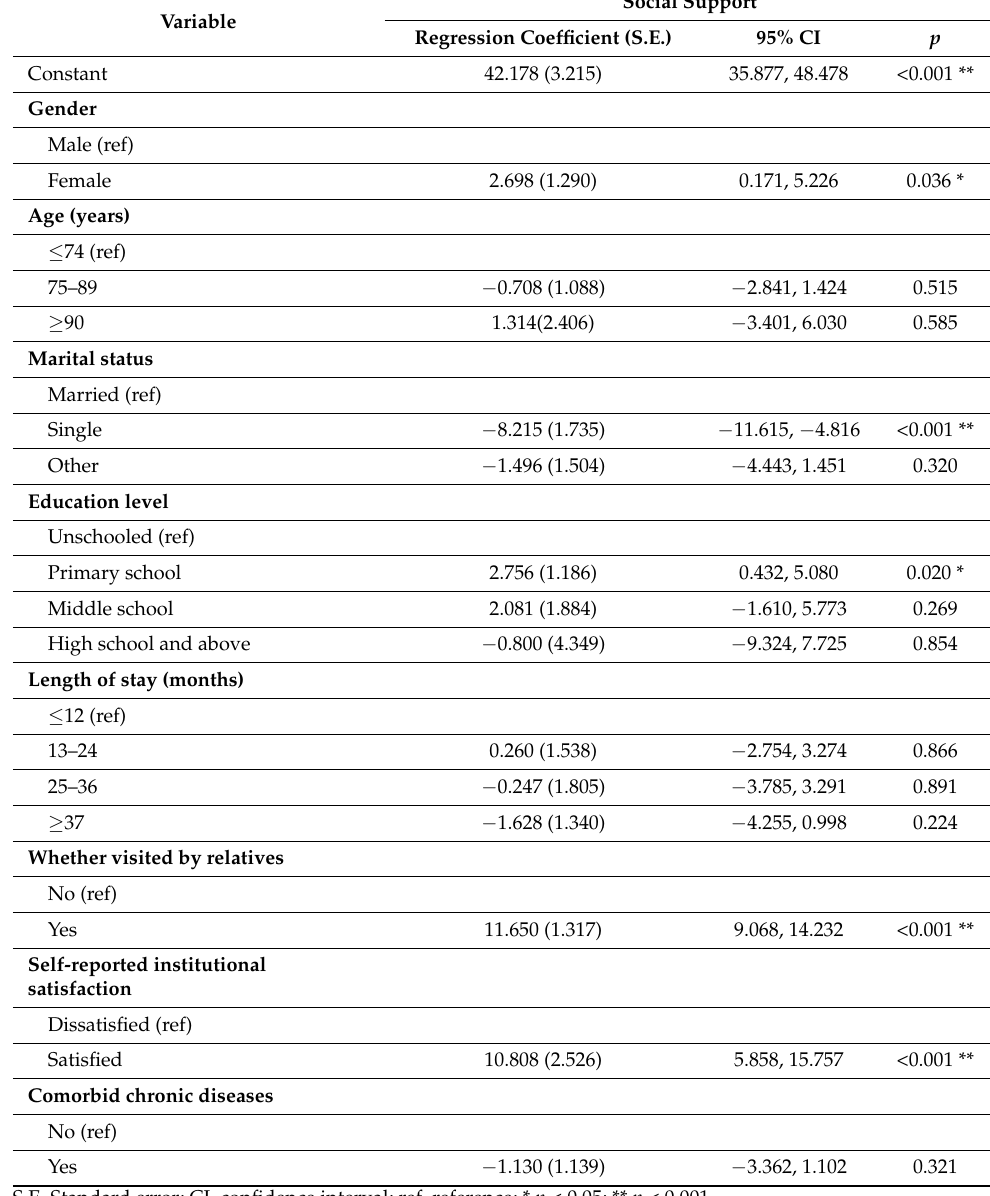
Table 3. Analysis results of the generalized linear model for the relationship between social support and sociodemographic variables among